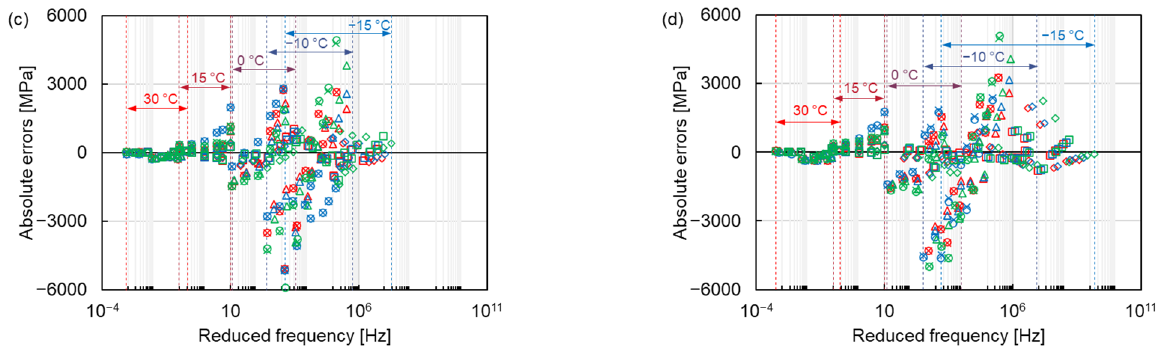
Figure 9. Absolute errors of ( a ) AC 11-NB, ( b ) AC 11-PMB, ( c ) SMA 11-NB and ( d ) SMA 11-PMB. The shift factor equation has more influence on the Sum of Absolute Error ( SAE ) than the master curve models, as shown in Figure 10. There are 15 master curve model-shift factor equation combinations for 4 types of mixtures resulting in a total of 60 fitting procedures. The average SAE of the fitting procedures with the controlled fitting condition are used for comparing the distinctions of the master curve models, shift factor equations and asphalt mixture types as expressed in Equation (14).